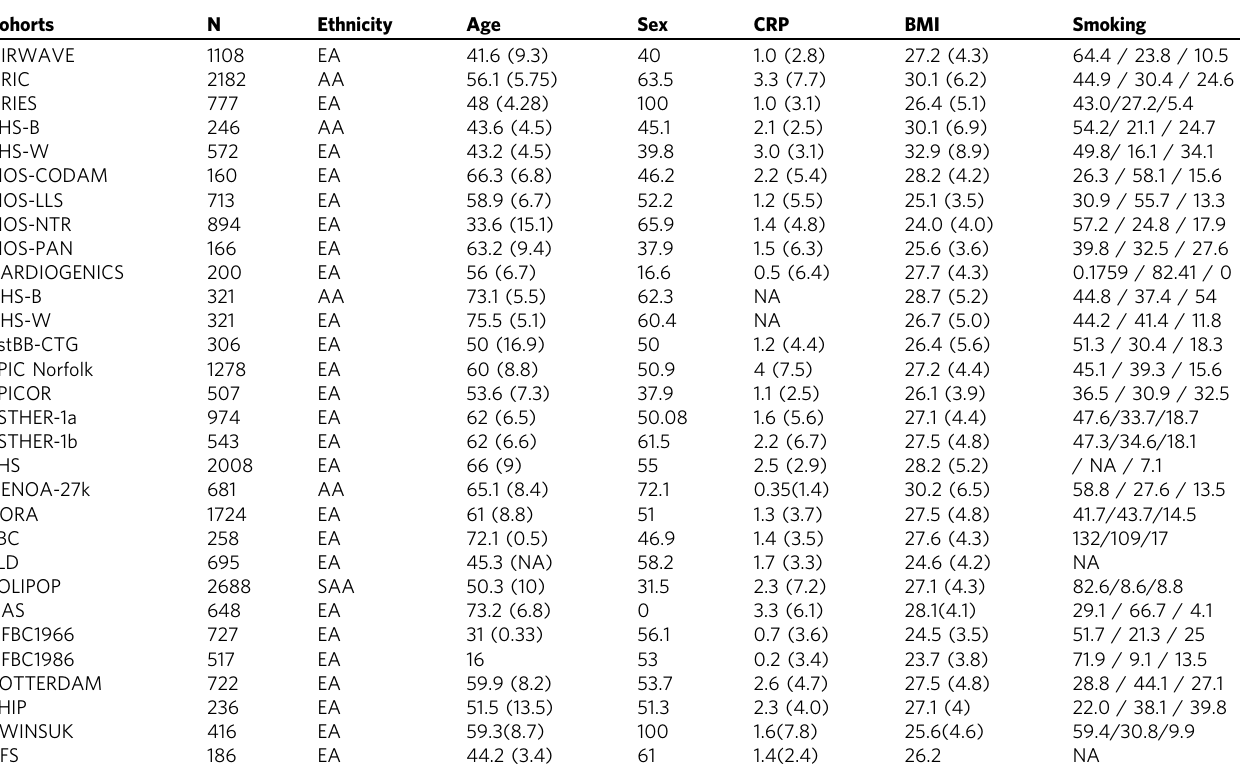
Column Cohorts gives all cohorts participating in the multi-ethnic meta-analysis in alphabetical order. N is the number of informative samples for this analysis. EA combines all European ancestries, AA combinesallAfricanAncestriesandSAAcombinesallSouthAsianancestries.Ageisgiveninyearsplusstandarddeviation.Sexisgivenaspercentfemaleineverycohort.CRPisthemedianofmeasured